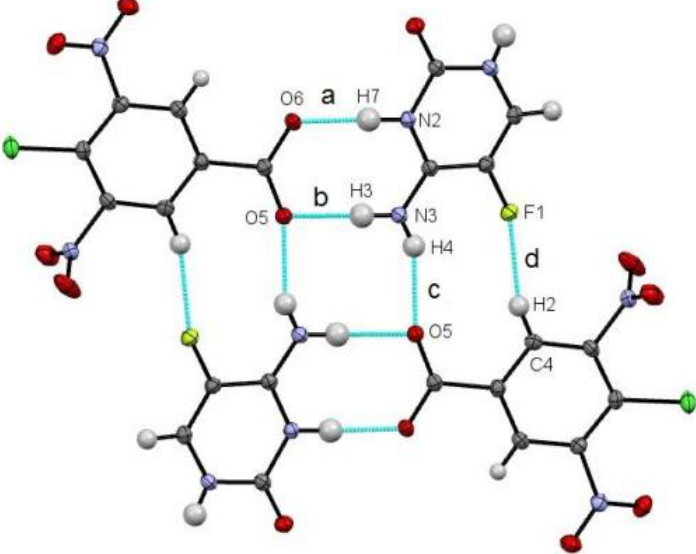
Figure 1. A tetramer unit of the 5FC-4Cl35DNBA molecular complex. ( a ) and ( b ) are the N–H···O hydrogen bonds forming the dimer; ( c ) and ( d ) are the N–H···O and C–H···F hydrogen bonds, respectively, that connect the two dimers together into the